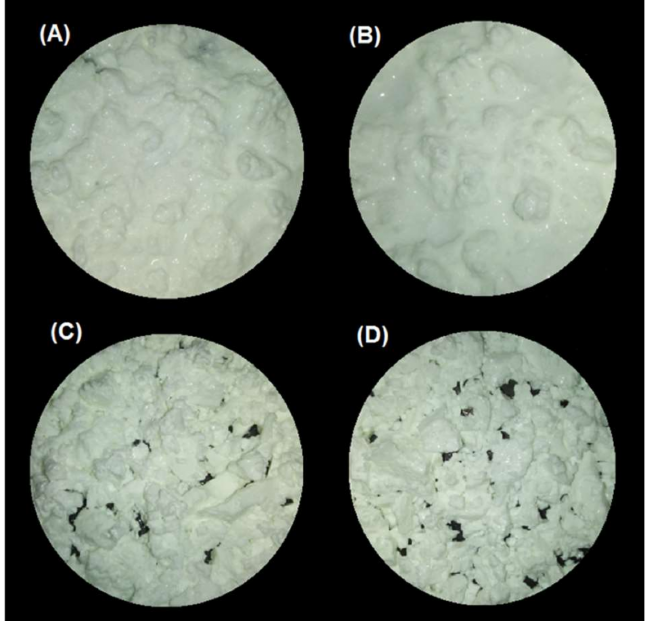
Figure 3. Images of the bolus obtained after oral digestion of the different emulsion gels stabilized by WPI. ( A ) pH 4/500 bar, ( B ) pH 4/1000 bar, ( C ) pH 7/500 bar, and ( D ) pH 7/1000